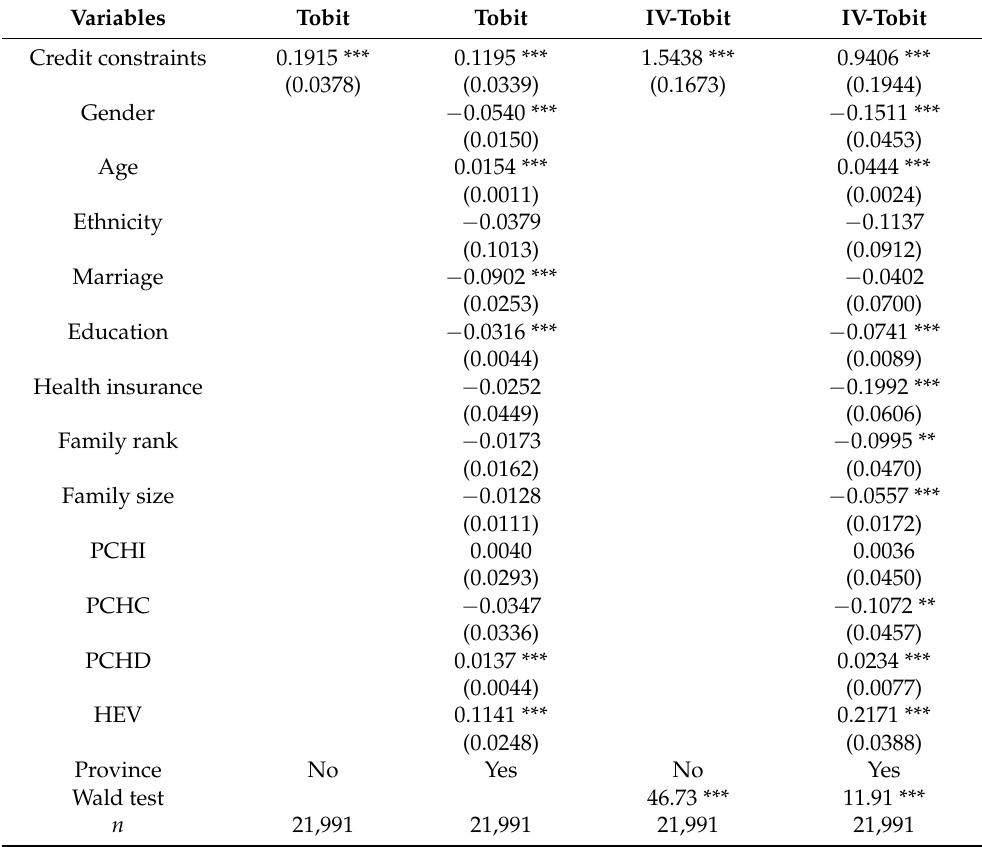
Table 6. Influence of formal credit constraints on rural residents’ illness days in 2013 (Tobit and IV-Tobit